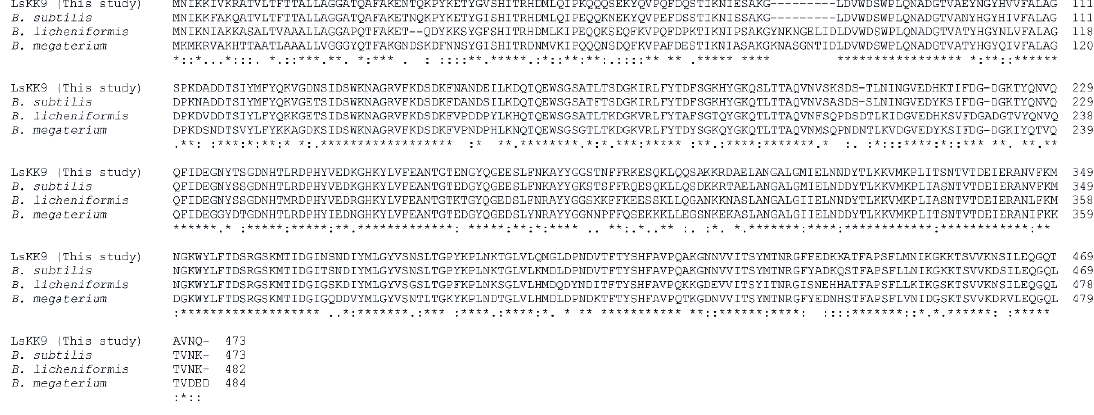
Figure 2. Sequence alignment of wild-type LsKK9 and other levansucrases. Sequences were compared with the following enzyme, source and accession numbers: Bs_SacB, B. subtilis subsp. subtilis str. 168 (GenBank: CAA26513.1); Bl_SacB, B. licheniformis 8-37-0-1 (GenBank: AGZ16261); Bm_SacB, B. megaterium DSM 319 (GenBank: ADF38395.1). The alignment was performed using Clustal Omega.